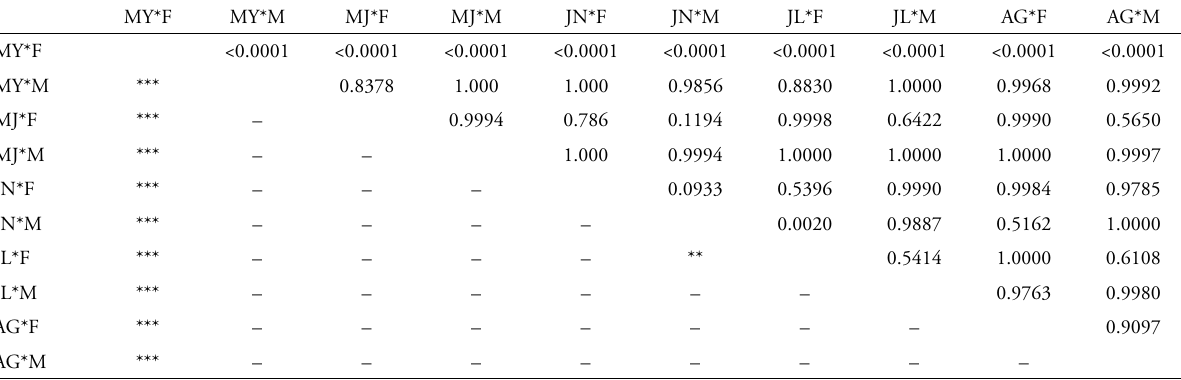
Table 1. Urobopyrus processae . Tukey-Kramer post hoc interactions of Least Square Means for effect of sample*sex on parasite total length (TL, in mm) in 2010. F = female, M = male, AG = August, JL = July, JN = June, MY = May, MJ = end of May/beginning of June, P > 0.05 = -, P < 0.05 = *, P < 0.01 = **, P < 0.001 = ***.